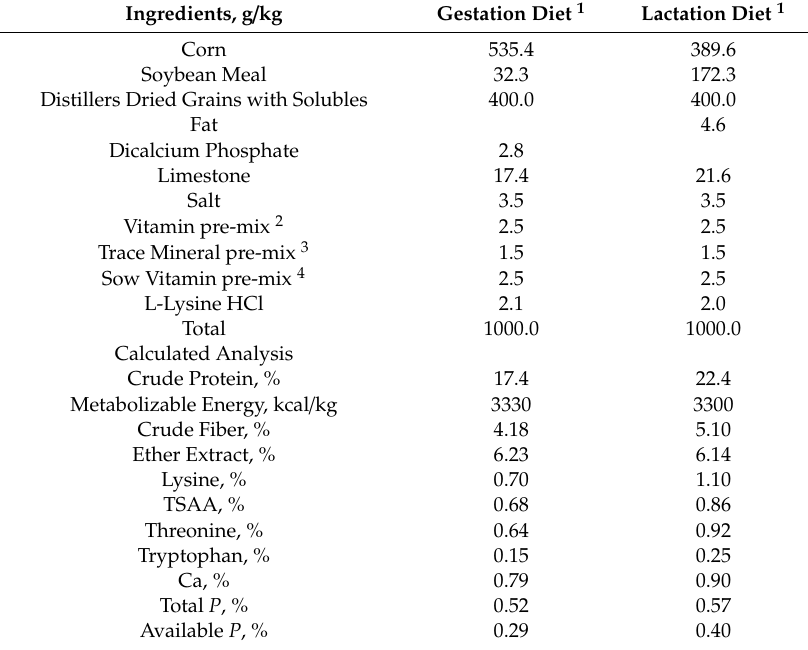
Table 1. Diet composition of the basal diet during gestation and